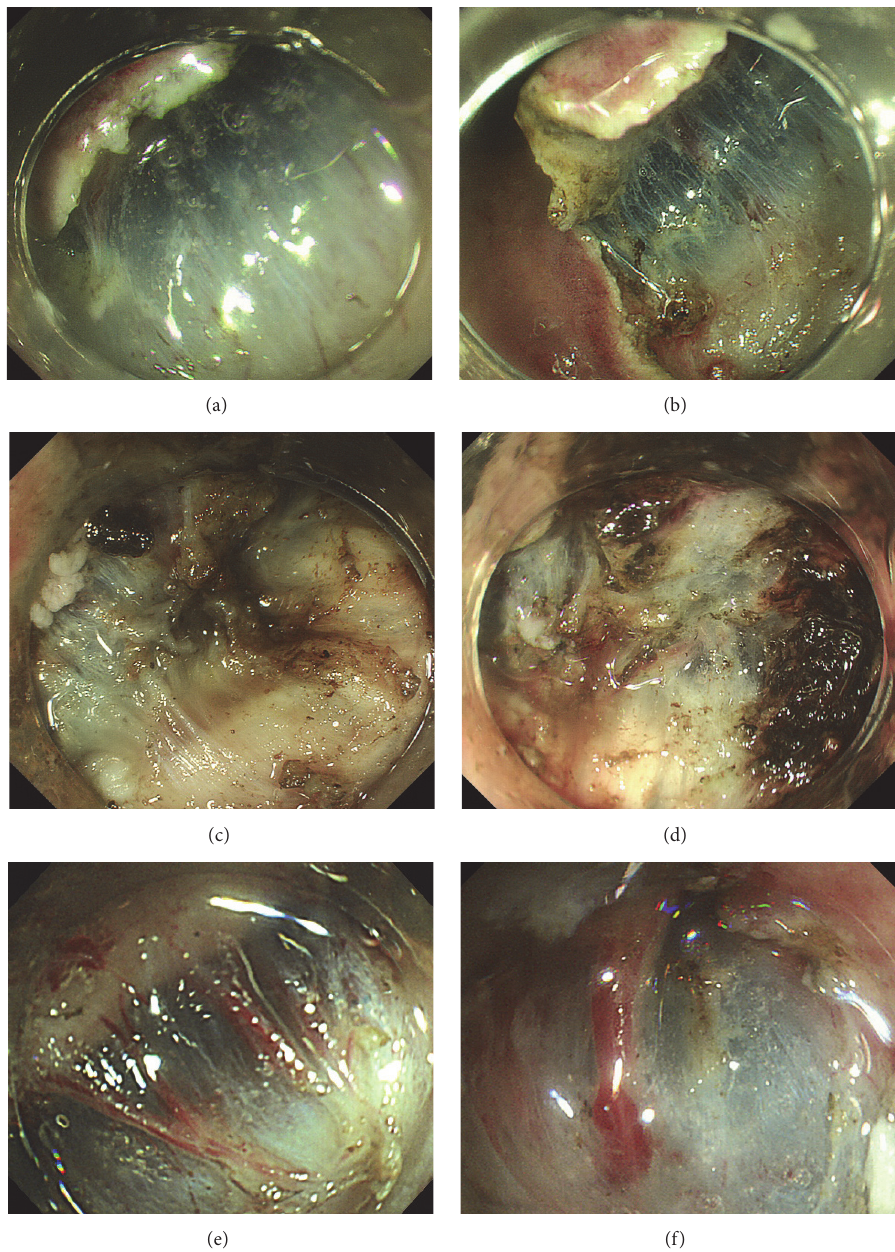
Figure 3: Variations of lesser curvature. (a, b) Easy case of submucosa. (c, d) “Hidden fibrosis.” (e, f) Many perforating vessel case.